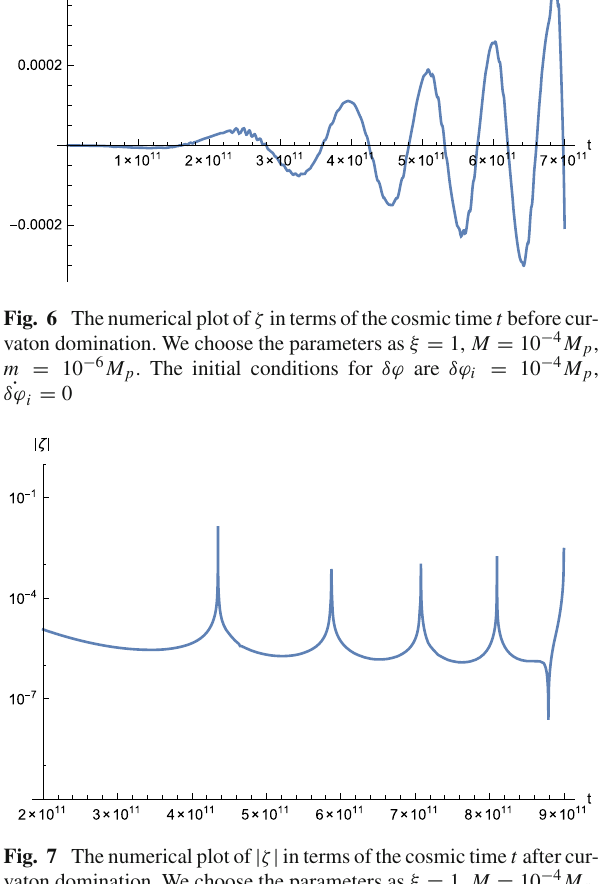
is equal to zero when ˙ ϕ = 0. This can also be seen in Fig. ˙ ζ = 2. So we still have 0, and ζ will not diverge. Note that